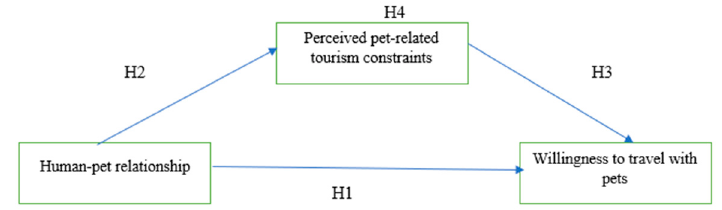
Figure 1. Theoretical framework with hypotheses .